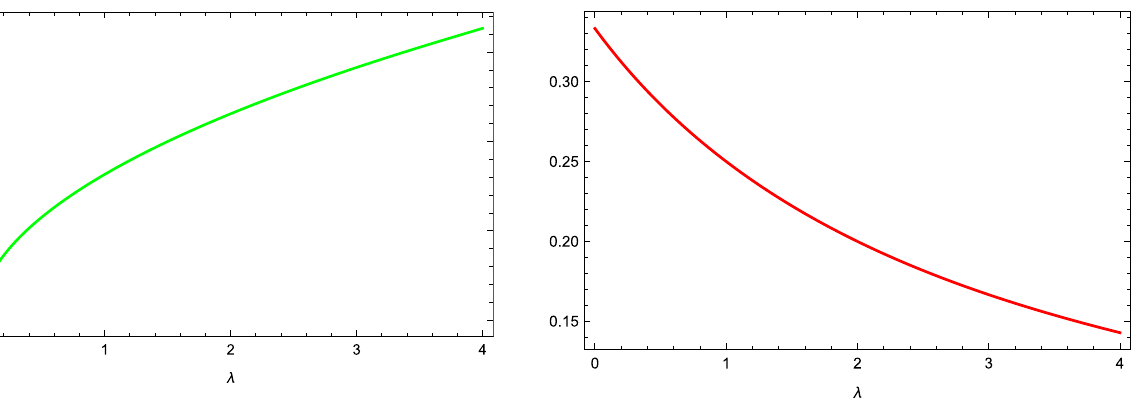
Fig. 5 Plot of EoS parameter ( ω ef f ) versus ( λ )